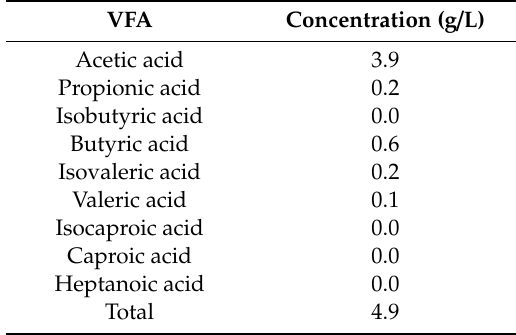
Table 3. Volatile fatty acid (VFA) concentration in feed samples.